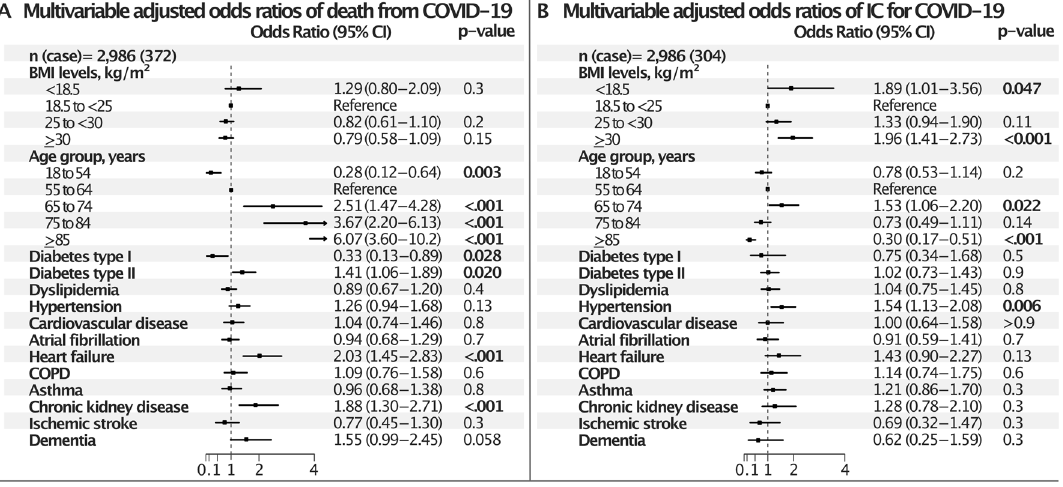
Figure 3. Multivariable adjusted odds ratios of IC and death from COVID-19, in women. COPD chronic obstructive pulmonary disease, IC intensive care. (A) Multivariable adjusted odds ratios of death, (B) multivariable adjusted odds ratios of IC.